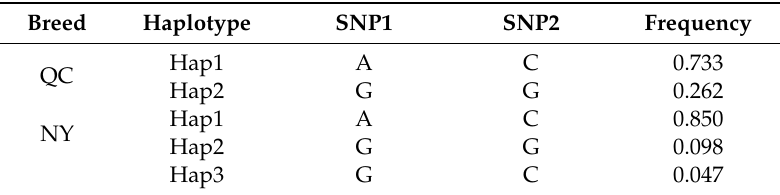
Table 3. Haplotypes of the two SNPs in bovine RET